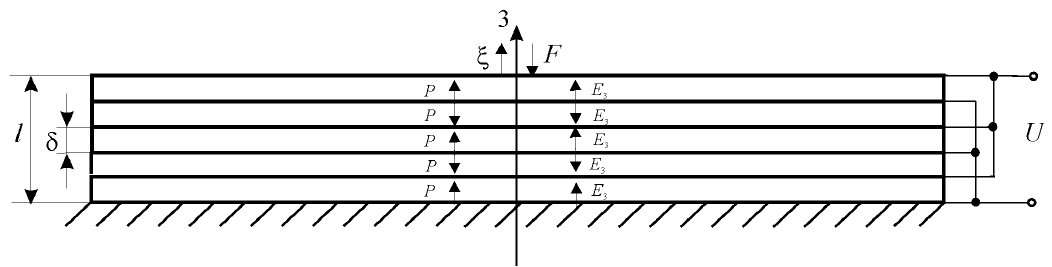
Figure 1. The kinematic scheme of a multilayer electroelastic engine with a longitudinal piezoeffect.